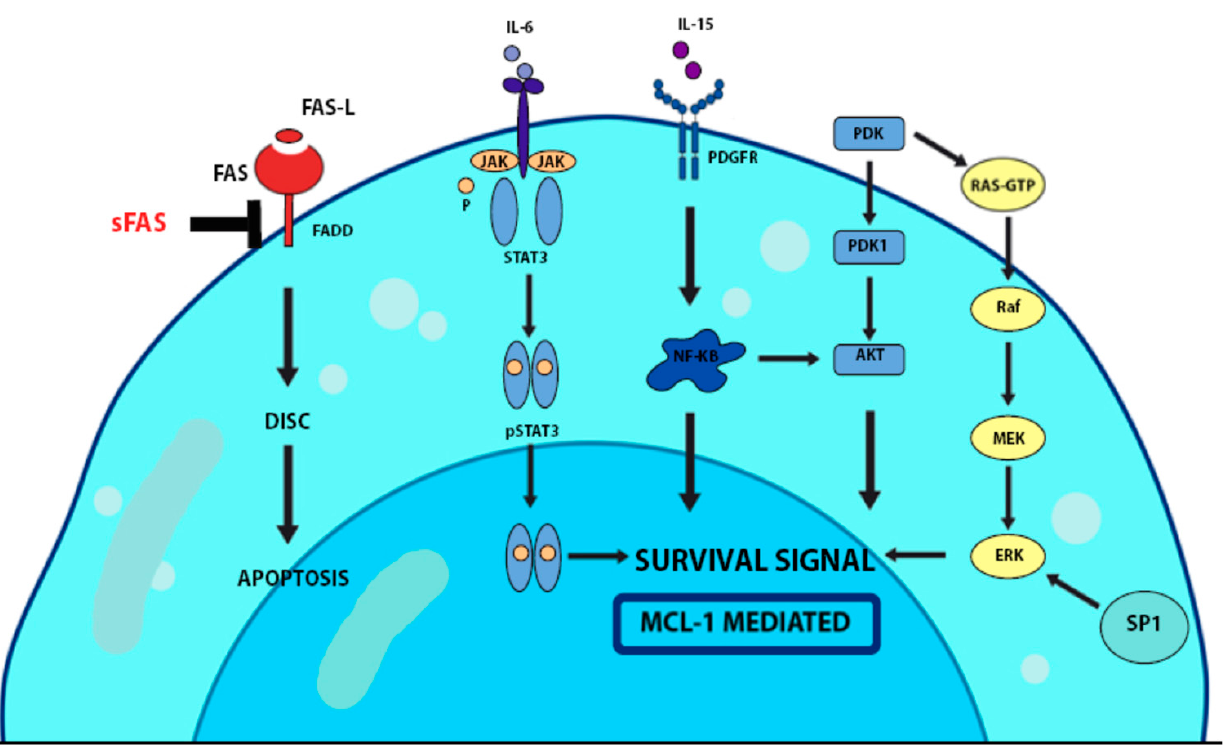
Figure 1. Molecular pathways involved in LGL leukemia.